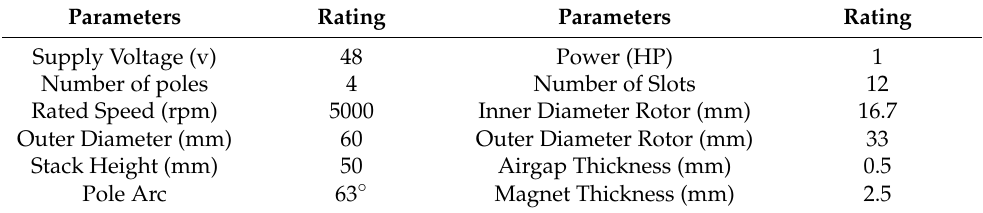
Figure 3. Flowchart for stator slots and windings. Table 1. Design